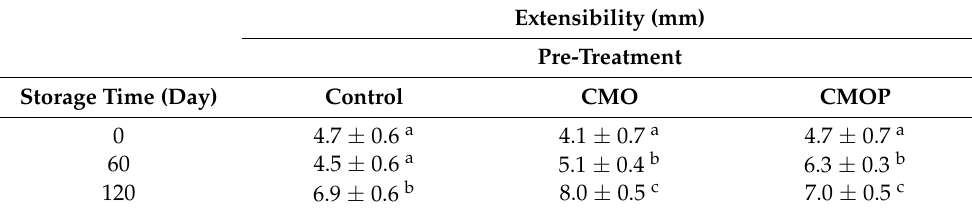
Table 9. Impact of storage time on the extensibility of dried apple slices